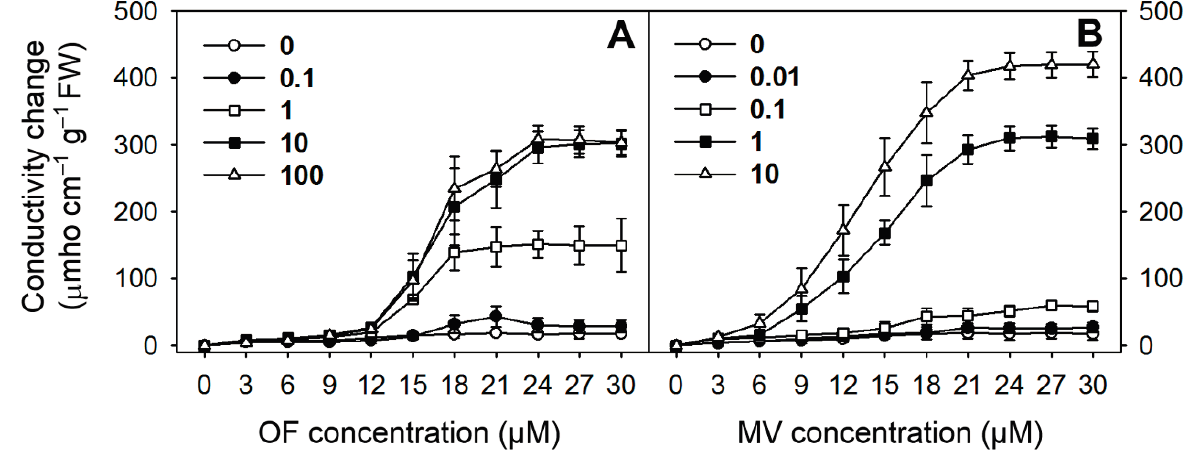
Figure 1. Effect of oxyfluorfen (OF) ( A ) and methyl viologen (MV) ( B ) on cellular leakage. Leaf segments were incubated with various concentrations of either OF or MV. Tissues were exposed to continuous white light at 250 µmol·m − 2 ·s − 1 photosynthetic photon flux density for 30 h following a 12-h dark incubation. Then conductivity, which reflects electrolyte leakage, was measured in the bathing solution for 30 h. Each symbol indicates the concentration of OF or